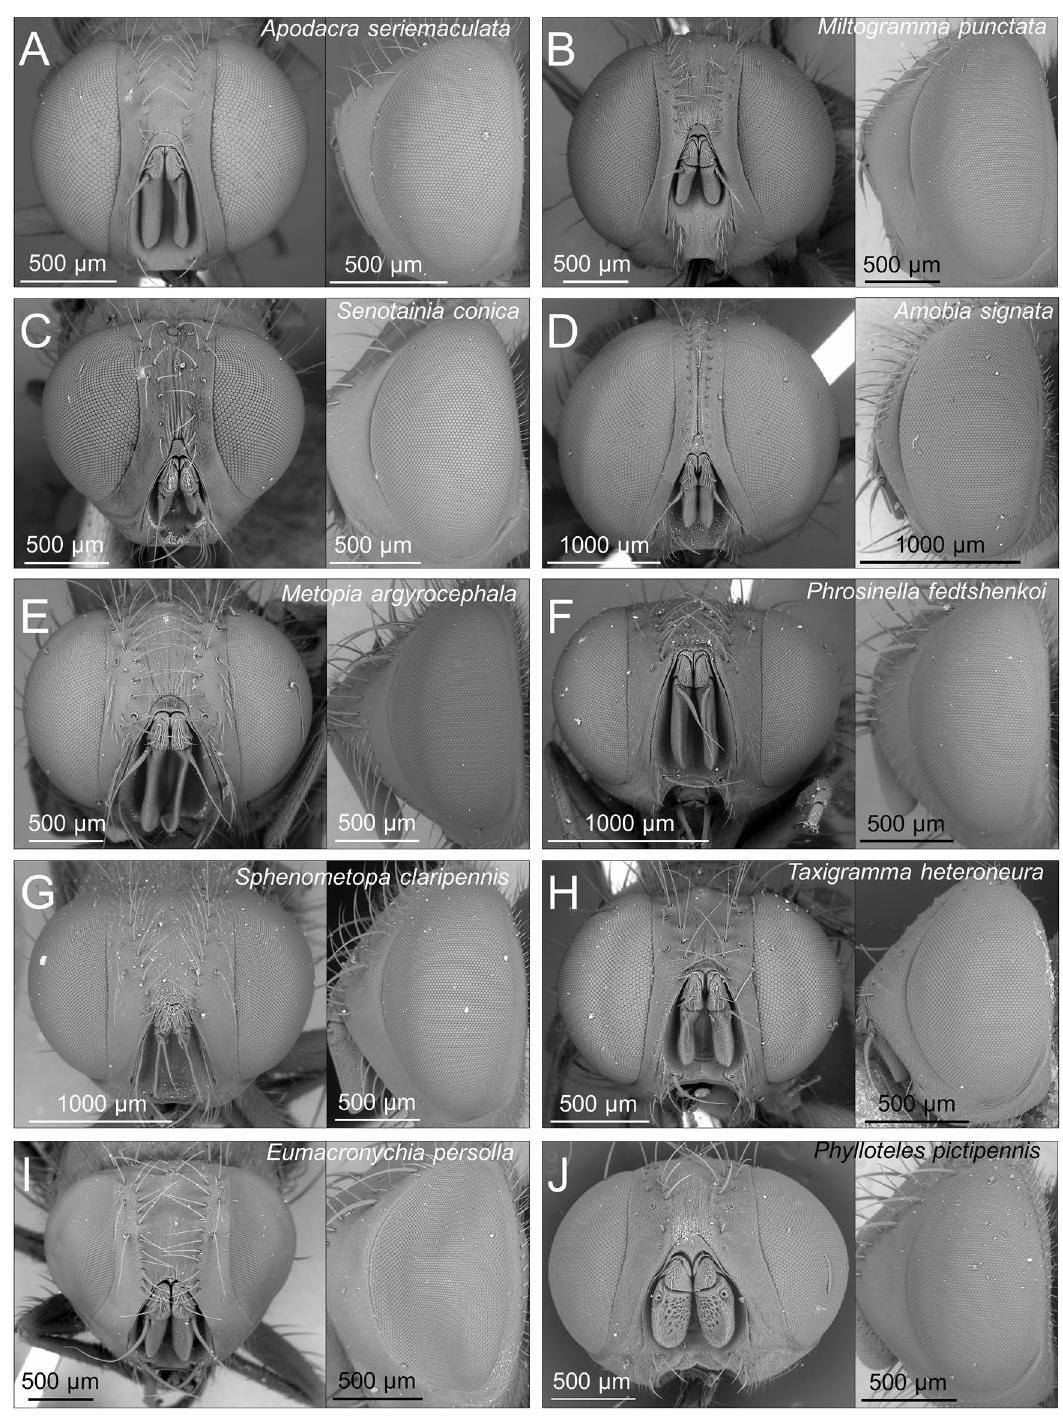
Figure 2. SEM pictures showing the variability of visual system in miltogrammine flies, as exemplified by a selection of the studied species. Head in frontal and lateral views are shown for each species. ( A ) Apodacra seriemaculata ; ( B ) Miltogramma punctata ; ( C ) Senotainia conica ; ( D ) Amobia signata ; ( E ) Metopia argyrocephala ; ( F ) Phrosinella fedtshenkoi ; ( G ) Sphenometopa claripennis ; ( H ) Taxigramma heteroneura ; ( I ) Eumacronychia persolla ; ( J ) Phylloteles pictipennis . ( A – D ) are SAT species, ( E – J ) are NON-SAT